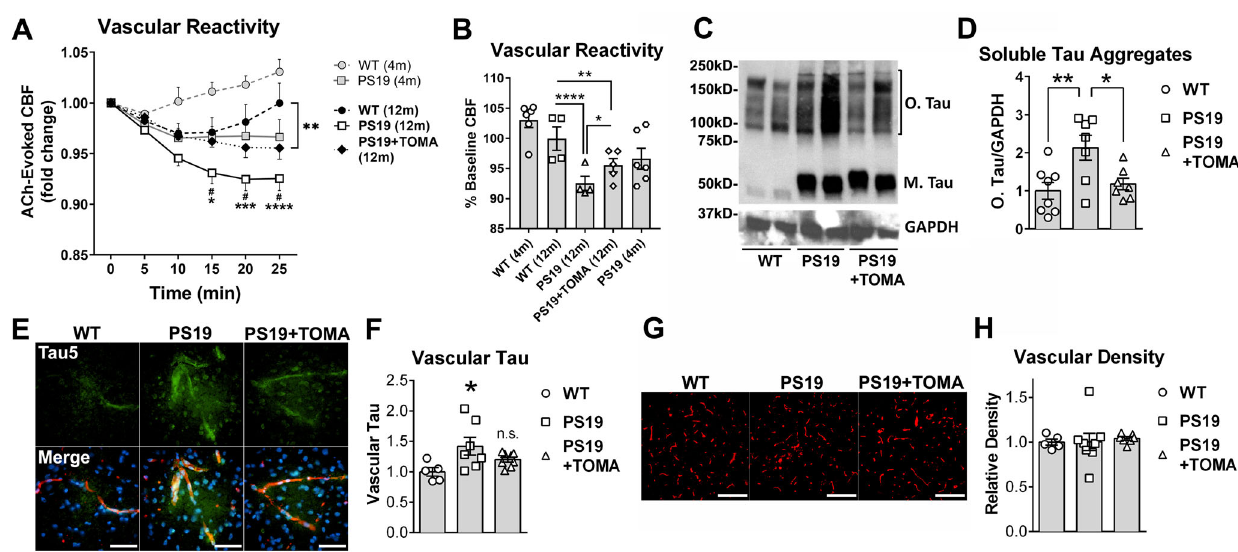
Fig. 6 | Removal of soluble tau aggregates from the brain ameliorates brain microvascularde fi citsin12-month-oldmaleandfemaleP301S(PS19)mice.A,B Treatment with TOMA ameliorates profound de fi cits in endothelium-dependent vascularresponsesinsomatosensorycortexofP301S(PS19)mice,restoringvascular responses to levels comparable to those of 4-month-old animals. A ACh-stimulated vascular responses; B Quantitative analyses of data at 25min in A. Interaction of time and treatment group by 2WRM ANOVA, F(10,50)=4.91, p <0.0001; difference from WT by Holm-Sidak ’ s p ost hoc indicated as *, t(60)=2.86, p =0.02; **, t(60) =3.33, p =0.003; ***, t(60)=4.04, p =0.0005; ****, t(60)=5.31, p <0.0001; # indi- catesdifferencefromPS19+TOMA,forall#s,t(60)>2.34,p<0.046byHolm-Sidak ’